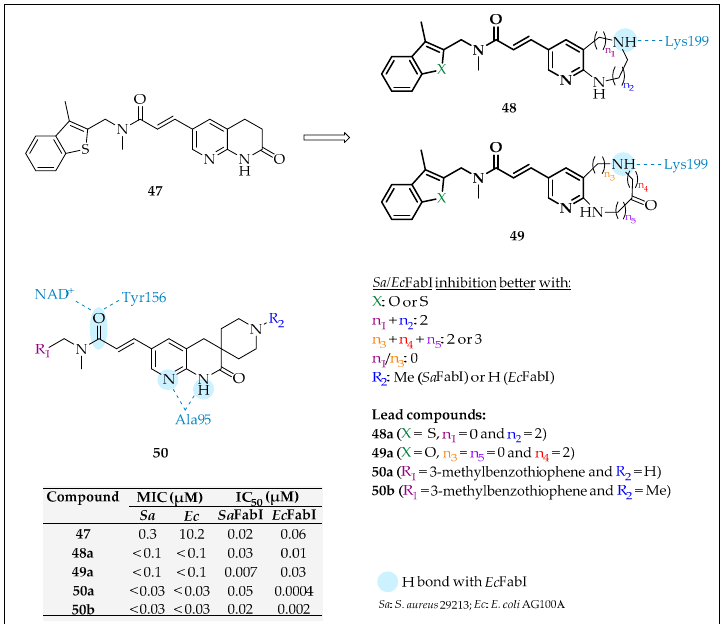
Figure 37. Structure, SAR and representation of main interactions with Ec FabI of 47–50 and in vitro activities of lead compounds [160,161].